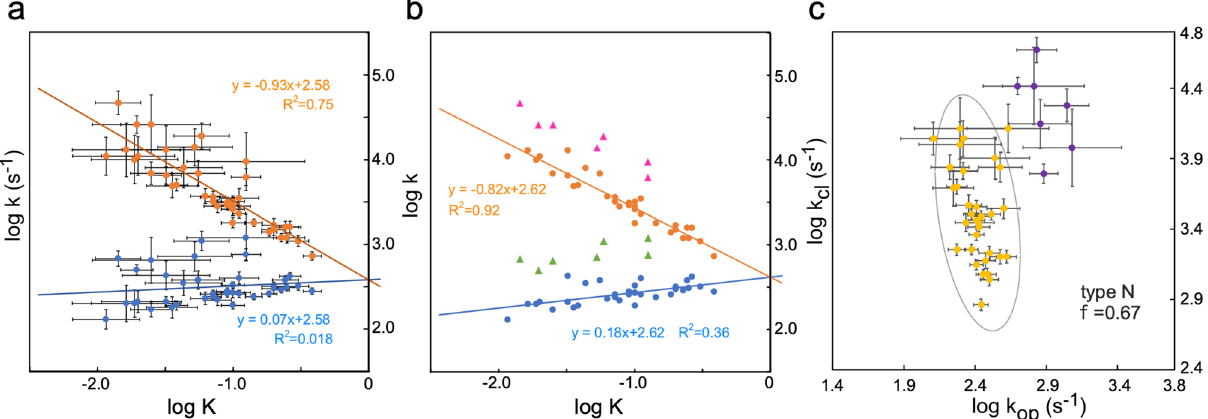
Figure 5. REFER plot and log k vs. log k ′ plot of apomyoglobin folding intermediates. ( a ) REFER plot using all observed residues with estimated fitting uncertainties 16 . The data points and least square lines of the log k op vs. log K plot and the log k cl vs. log K plot are blue and orange, respectively. ( b ) Replot. Outlier residues (green and magenta) were removed to redraw the least-square lines (blue and orange). See Supplementary Fig. S4 for details. ( c ) Log k vs. log k ′ plot. The yellow dots are the residues contributing to the least-square lines, and the purple dots are the outlier residues in ( b ). The yellow group belongs to type N. The yellow dots are enclosed by a 95% confidence